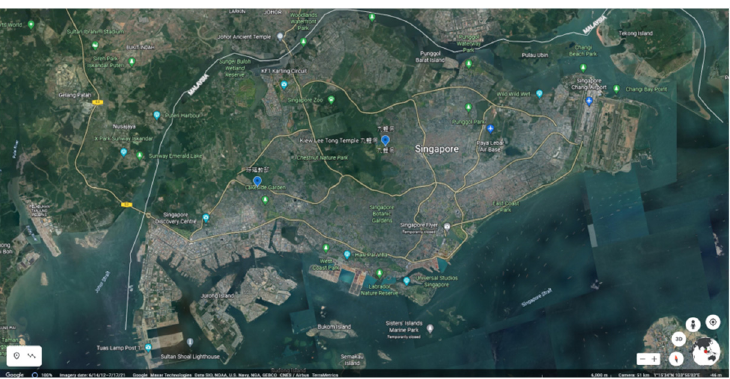
Figure 2. Satellite distance between Kiew Lee Tong ( 九鲤洞 ) and Qiong Yao Jiao Di ( 琼瑶教邸 ) in 1979.